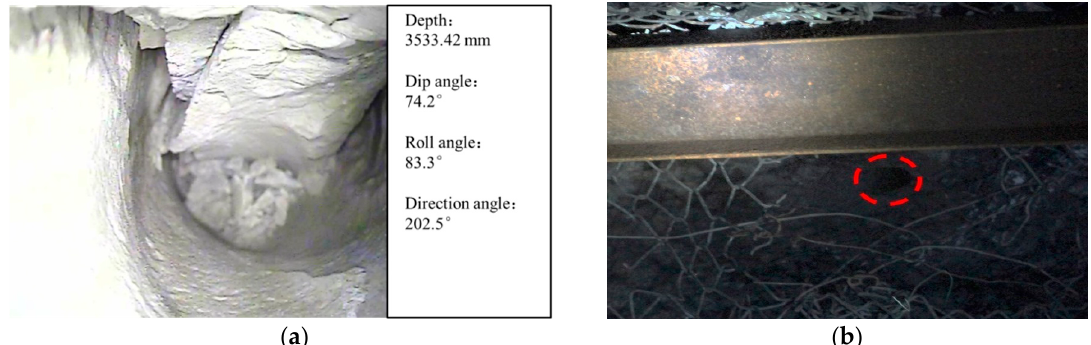
Figure 7. Images of hole plugging and roof crushing: ( a ) hole plugging; ( b ) roof crushing.